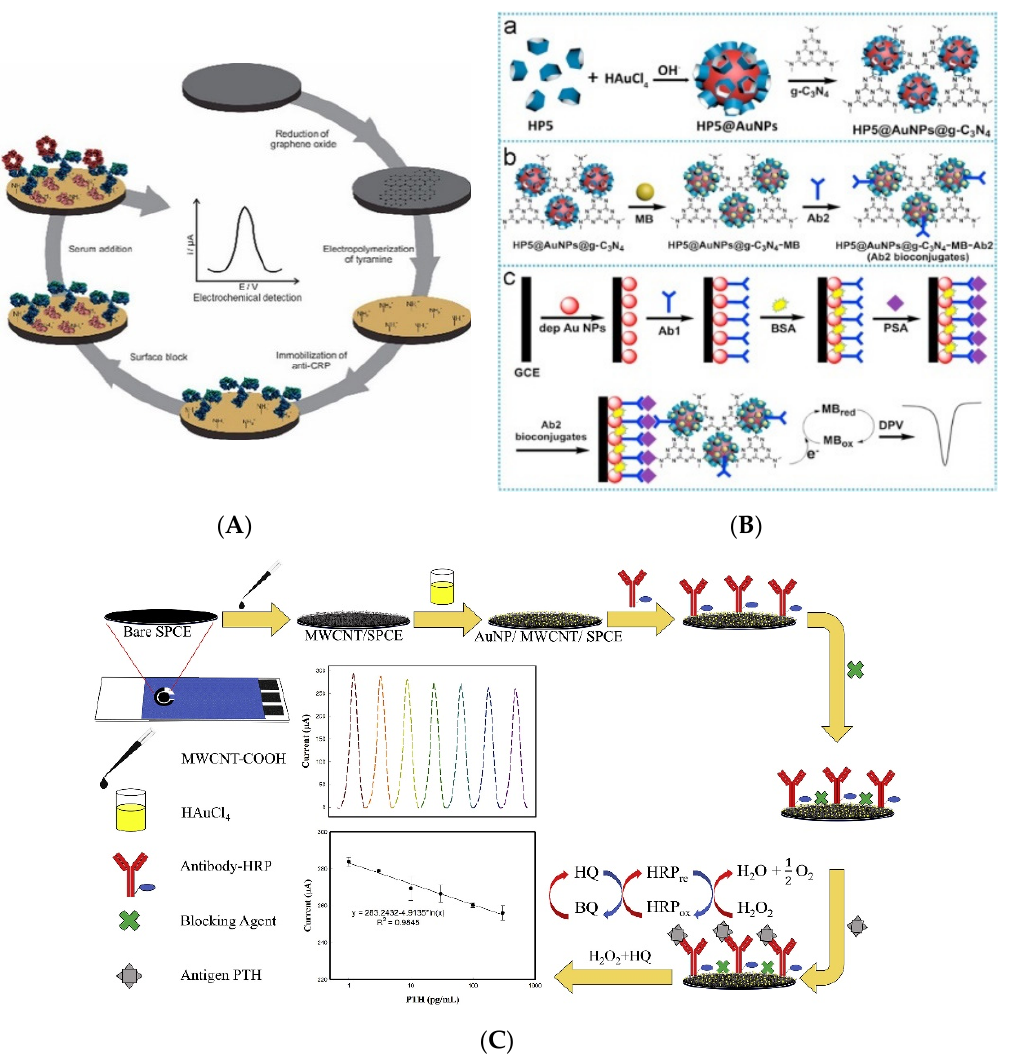
Figure 1. Examples of voltammetric immunosensors with non-covalently immobilized antibodies. ( A ) Schematic diagram of CRP immunosensor. Antibodies were immobilized on the polymer-modified electrode by the charge interaction. Reproduced with permission from [30]. Copyright (2020) John Wiley and Sons., Inc. ( B ) Immunosensor with non-covalently immobilized antibodies on AuNPs. Reproduced with permission from [33]. Copyright (2018) Elsevier. ( C ) Schematic diagram of immunosensor using gold and carbon-based materials at the same time. Reproduced with permission from [41]. Copyright (2021) Elsevier.